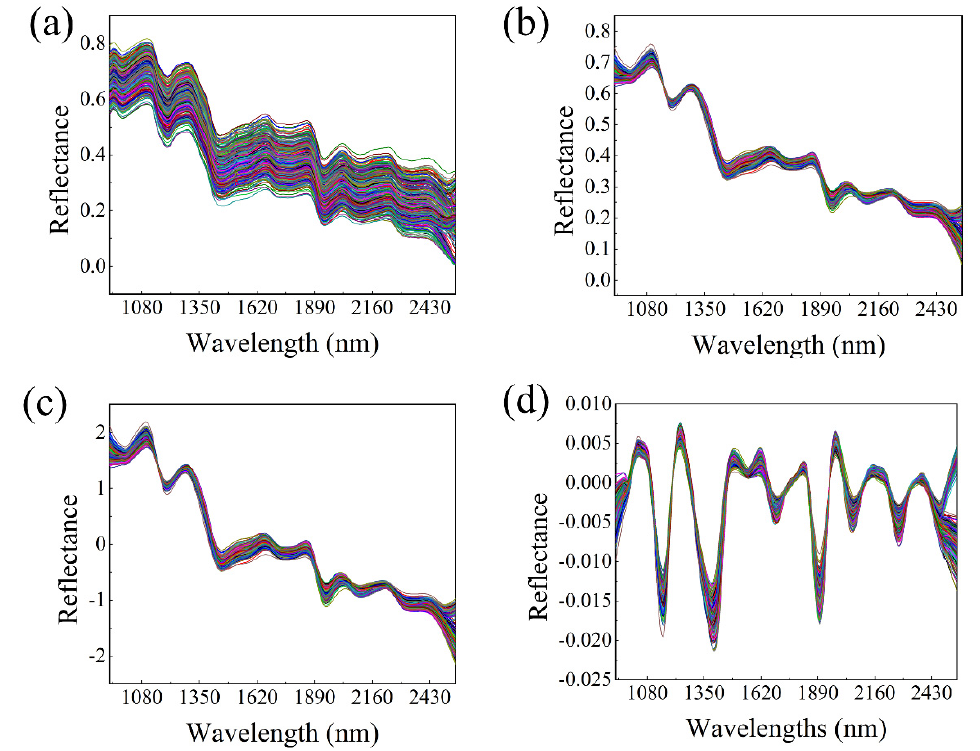
Figure 2. The average spectra of the embryo side of maize seeds. ( a ) The raw spectra curves; ( b ) the spectra curves pretreated by SG − MSC; ( c ) the spectra curves pretreated by SG − SN; ( d ) the spectra curve pretreated by SG − 1Der.